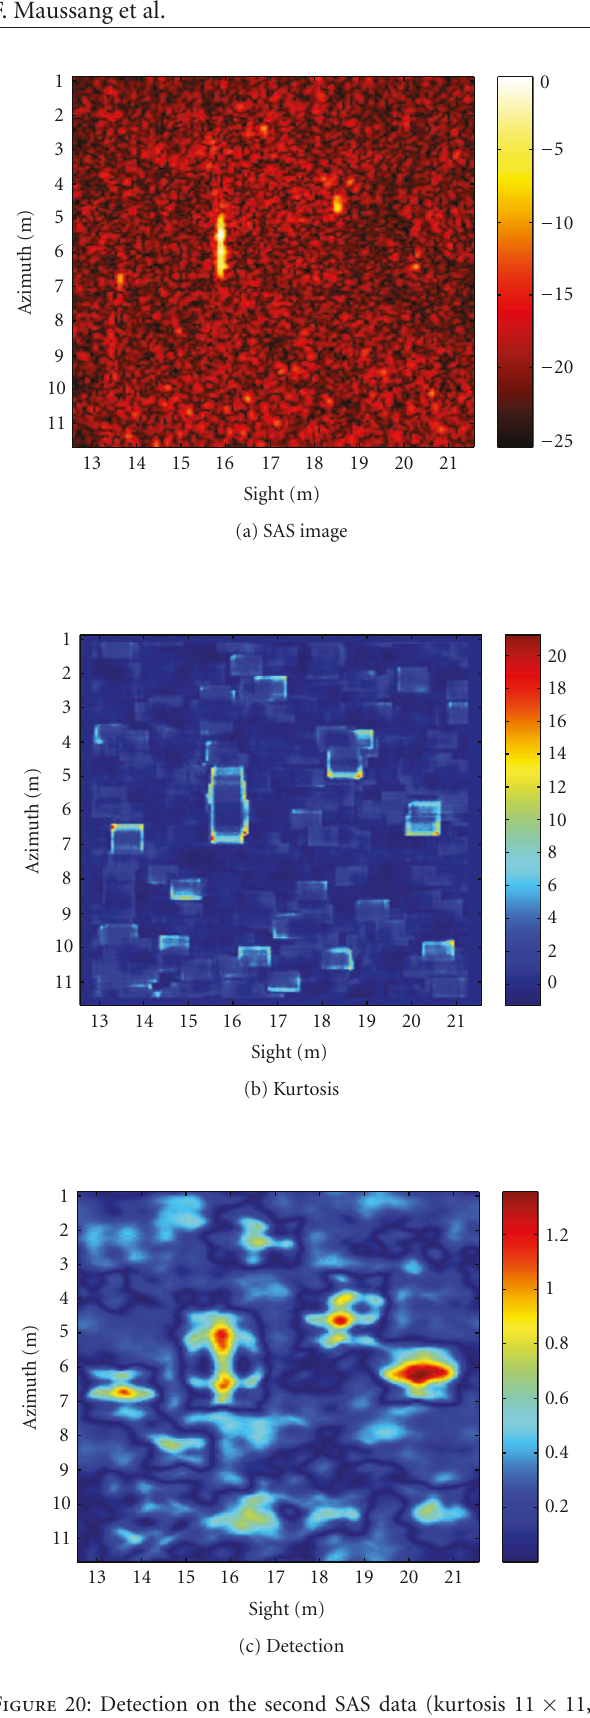
Figure 20: Detection on the second SAS data (kurtosis 11 × 11, matched filtering 15 × 15, SD =